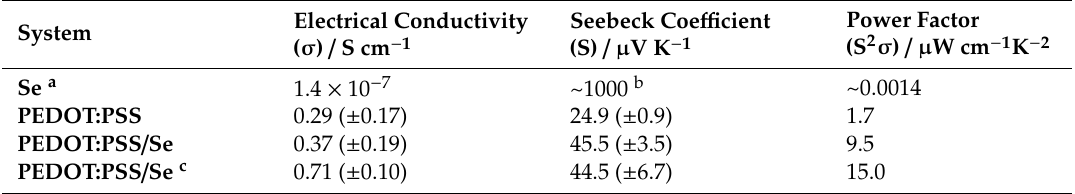
Table 1. Thermoelectric properties of PEDOT:PSS / Se and control films at room temperature. Electrical Conductivity Seebeck Coe ffi System ( σ ) / S cm − 1